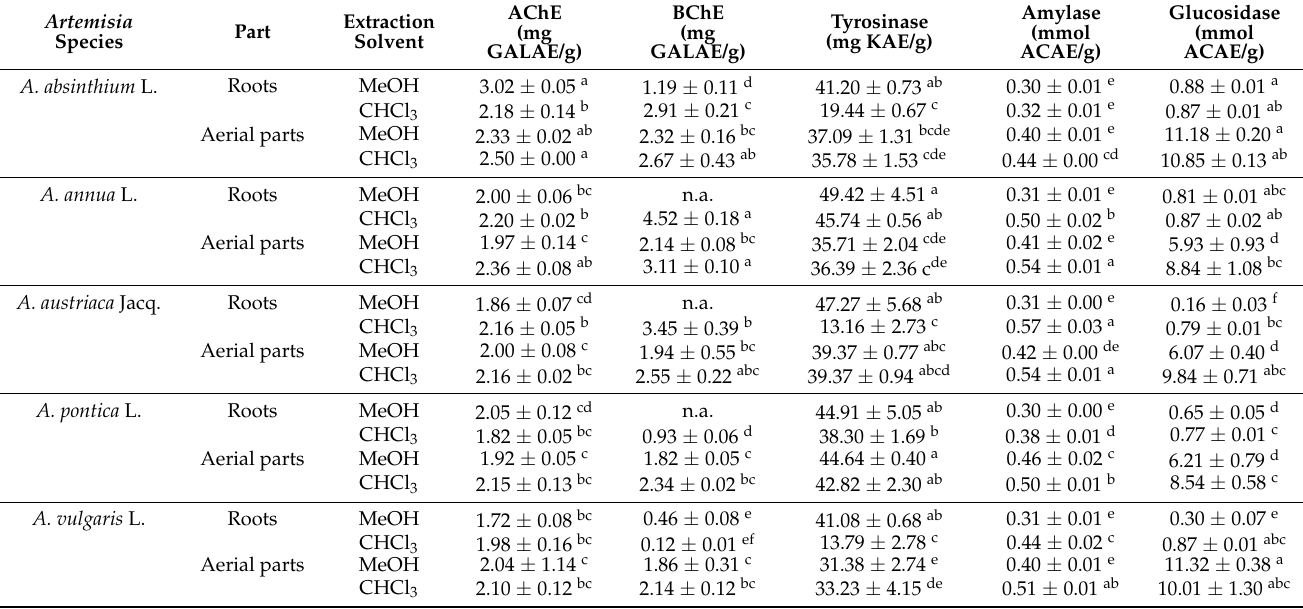
Table 4. Enzyme inhibitory activity of Artemisia spp.